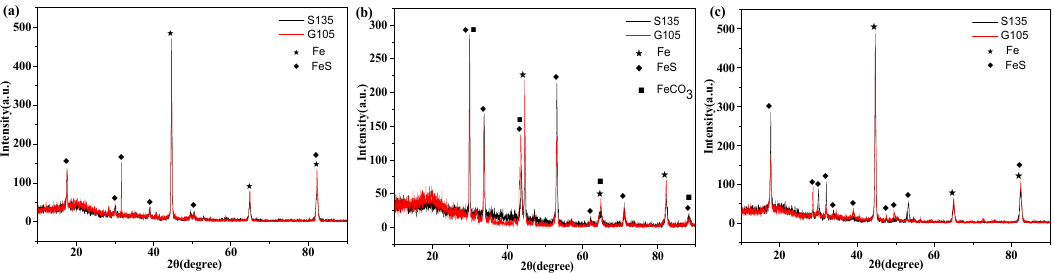
Figure 4. XRD spectrum of corrosion products of two test string materials under different tempera- tures: ( a ) room temperature; ( b ) 100 °C; ( c ) 180 °C.